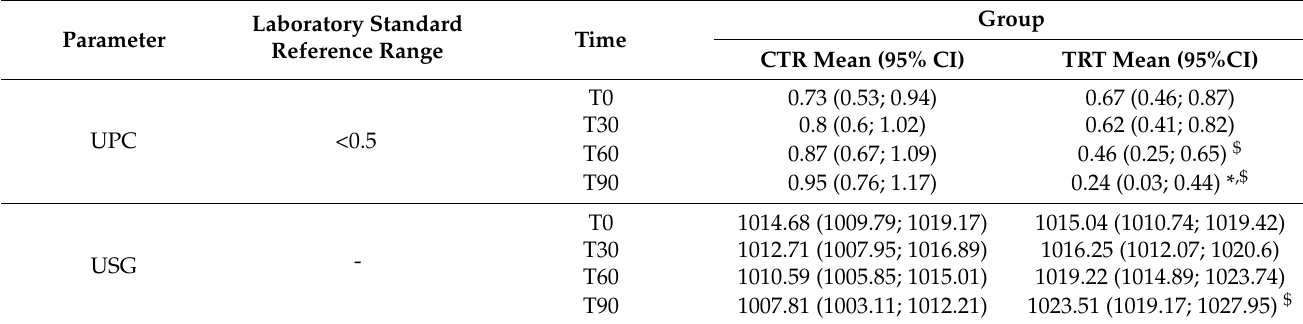
Table 6. Urinary parameters: proteinuria (UPC) and urinary specify gravity